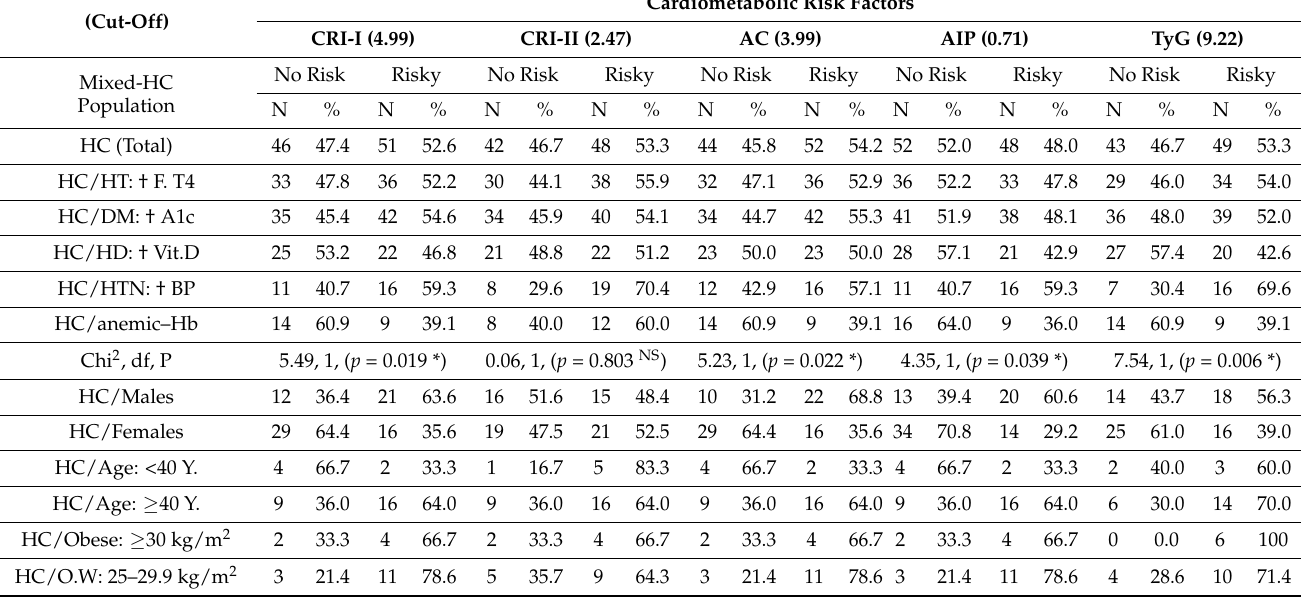
Table 5. Prevalence of cardiometabolic risk factors in mixed-hypercholesterolemic (HC: ≥ 200